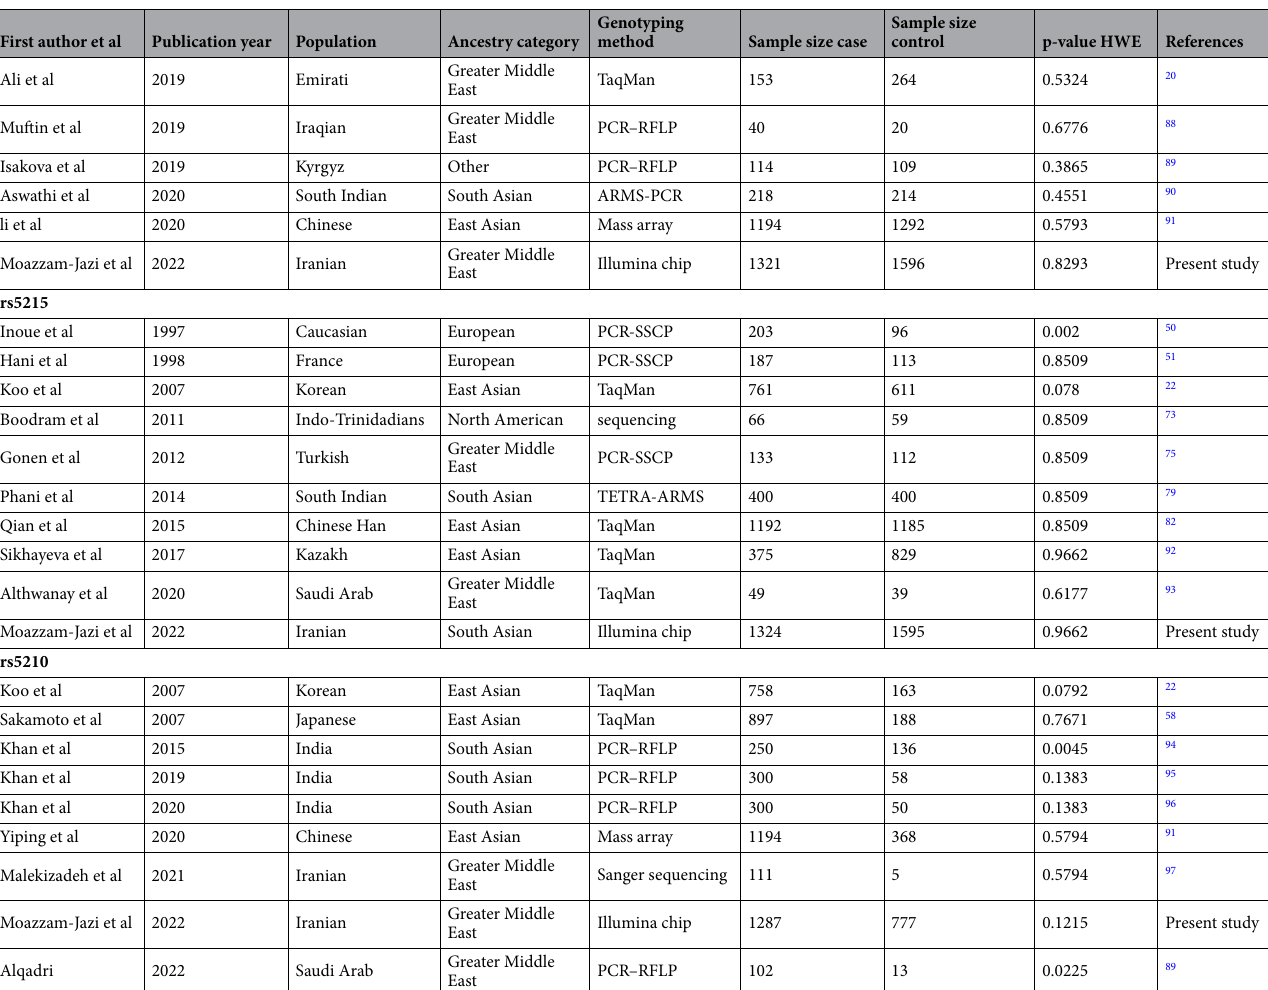
Table 1. Characteristics of the studies included in the present meta-analysis (n =